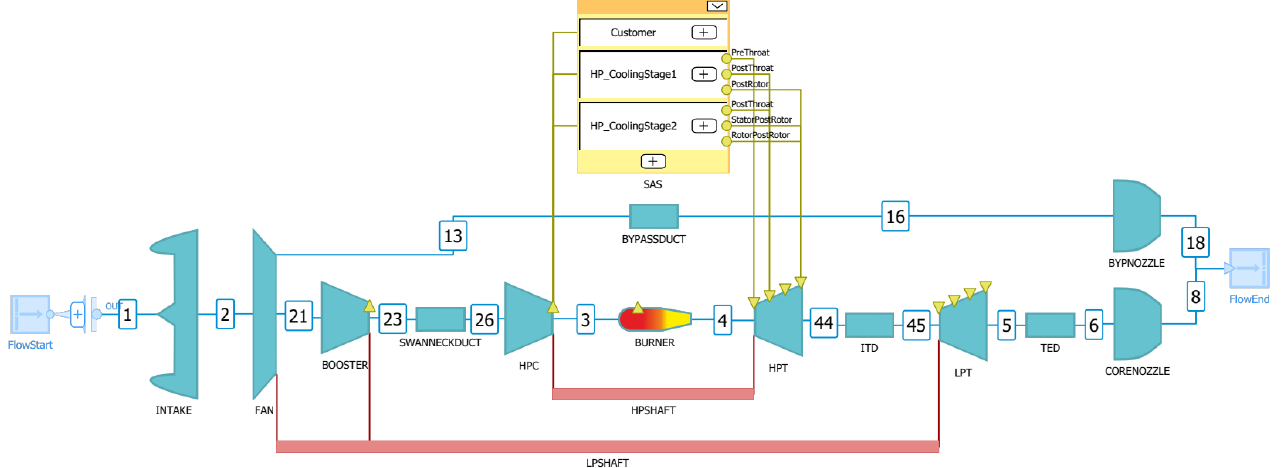
Figure 5. Schematic view of the engine architecture in the virtual engine platform Gas Turbine Laboratory (GTlab)